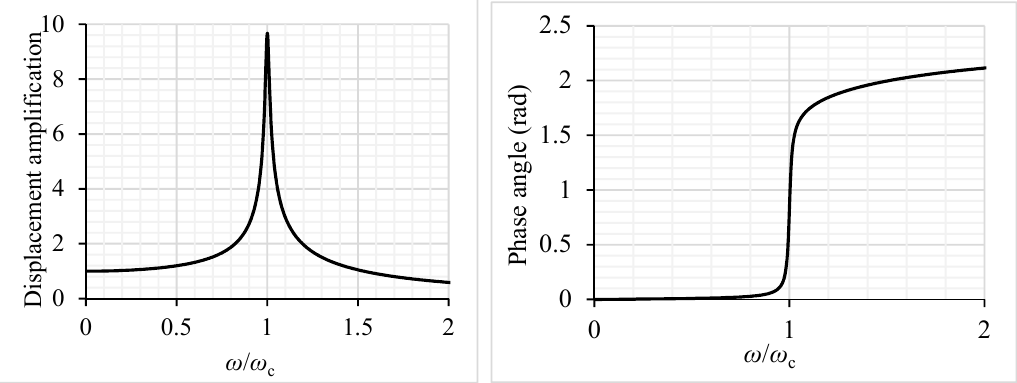
Figure 11. Displacement amplification factor and phase angle of an infinitely long isotropic plate subjected to a concentrated load ( D d,r = 9.67).